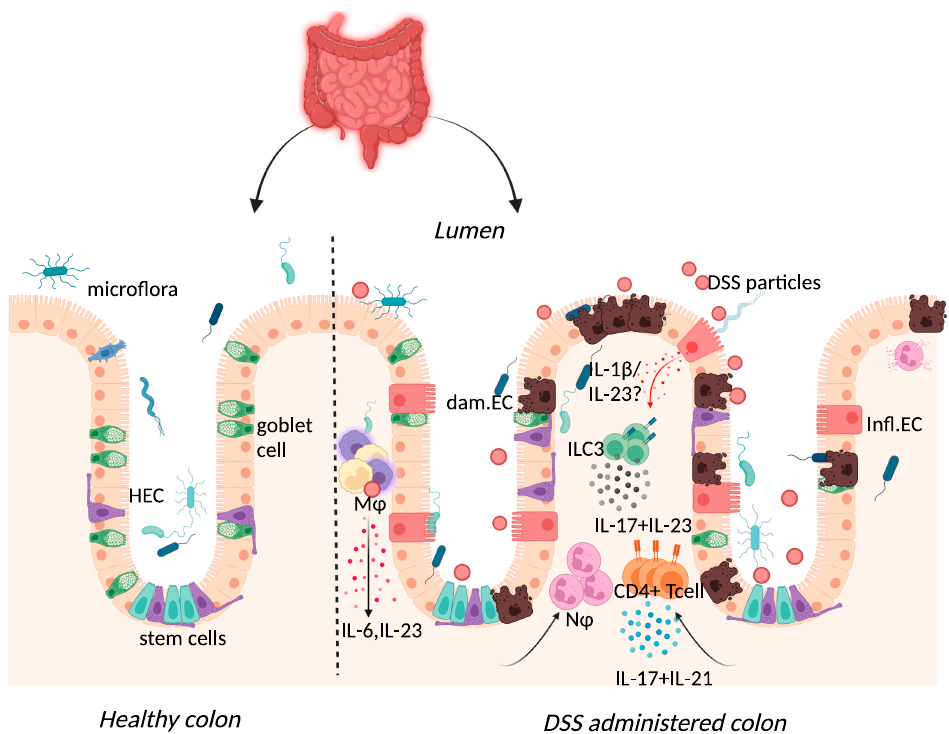
Figure 2. Immune response to DSS administration. DSS administration results in epithelial release of IL-1 β , activation of ILC3, and release of IL-23. IL-23 release results in the influx of neutrophils and CD4+ T cells, which further respond through enhanced IL-17 signalling. The resulting chronic inflammatory responses result in goblet cell depletion, increased intestinal permeability, and increased adhesion of commensal intestinal microbiota to the epithelium. Key: Inflamed epithelial cells (Infl.EC), healthy epithelial cells (HEC), damaged epithelial cell (dam.EC), macrophages (M Φ ), neutrophils (N Φ ). Created with BioRender.com, accessed on 18 August 2022.